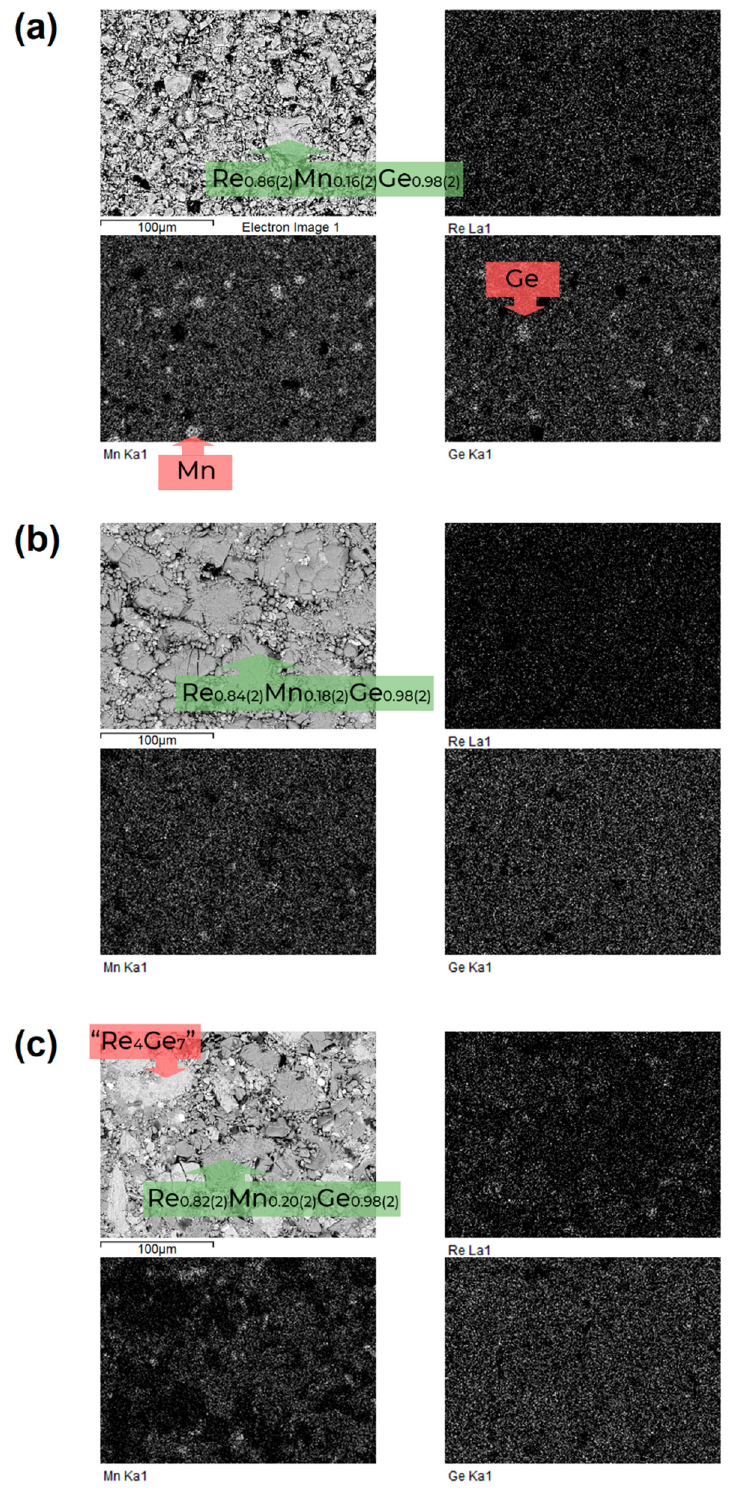
Figure 4. EDX mapping of the elements for the samples with nominal ratio of metals: Mn 0.85 Re 0.15 Ge ( a ), Mn 0.80 Re 0.20 Ge ( b ), and Mn 0.60 Re 0.40 Ge ( c ). The Mn 0.80 Re 0.20 Ge sample ( x refined = 0.177(7)) with a minor impurity and the newly syn- thesized sample with x nominal = 0.17 ( x refined = 0.169(6)) were studied to refine the crystal struc- ture of Mn 1 − x Re x Ge. As expected, Mn 1 − x Re x Ge crystallizes in the cubic FeSi structure type (Space group P2 1 3 ). In this case, we do not observe any peaks responsible for the formation